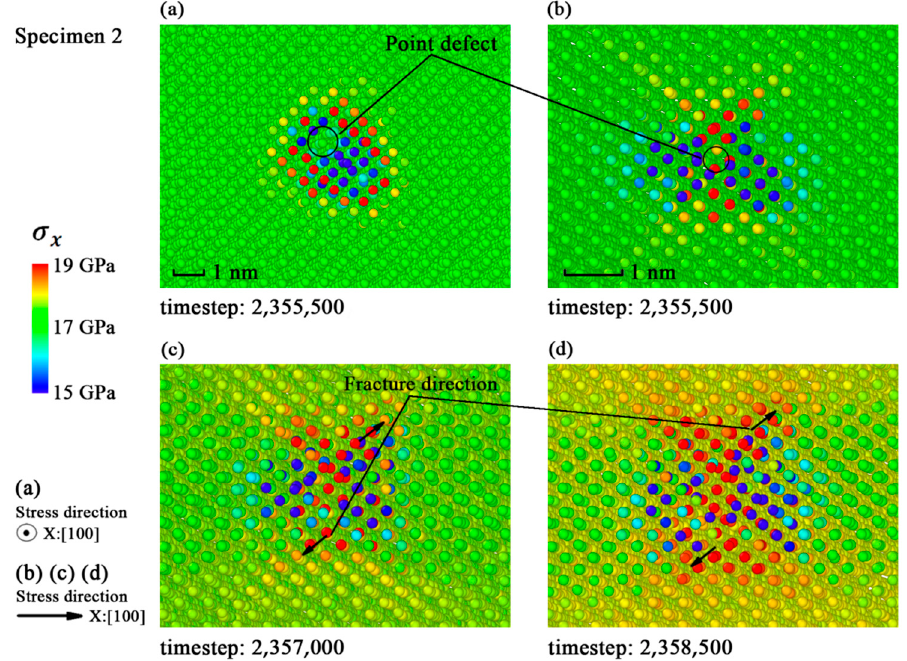
Figure 4. Distribution of σ x in specimen 2 before fracture: ( a ) Snapshot at timestep 2,355,500; ( b ) snapshot at timestep 2,355,500; ( c ) snapshot at timestep 2,357,000; ( d ) snapshot at timestep 2,358,500.